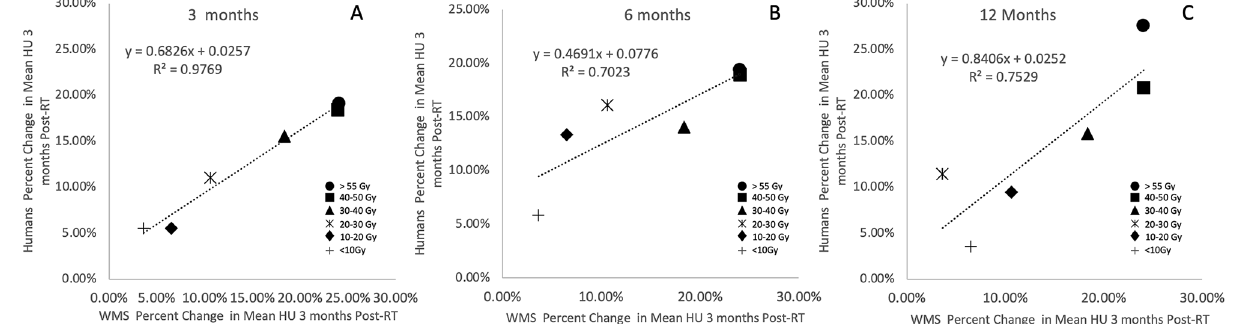
Figure 6. Correlation between the changes seen in the swine at 3 months post-RT and the humans at different timepoints post-RT. Each point represents a dose bin where analysis was performed. ( A ) Correlation between the humans at 3 months and swine at 3 months. ( B ) Correlation between the humans at 12 months and swine at 3 months. A curve was fit to all data sets and Pearson stats showed strong correlation with the swine